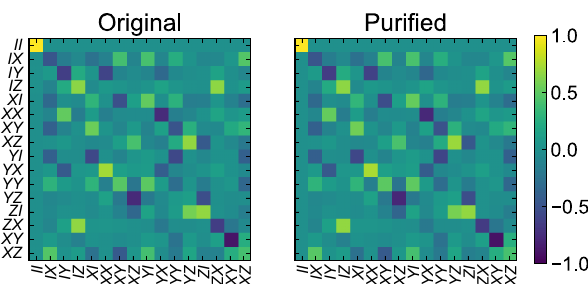
FIG. 6. Pauli transfer matrices of entangling gates generated by a CCR drive with a duration of 216.9 ns before (left) and after (right) channel purification, which roughly corresponds to the point shown by a star in Fig. 2(b).